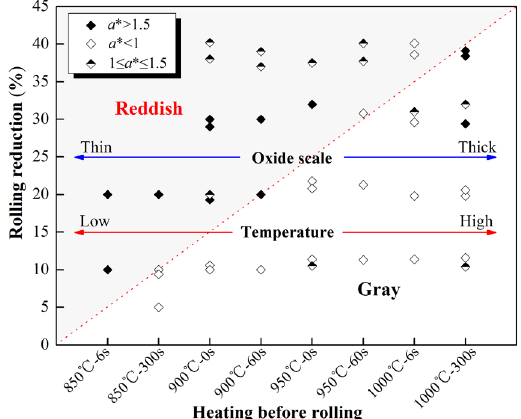
Figure 8. The relationship between rolling conditions and surface red degree value a